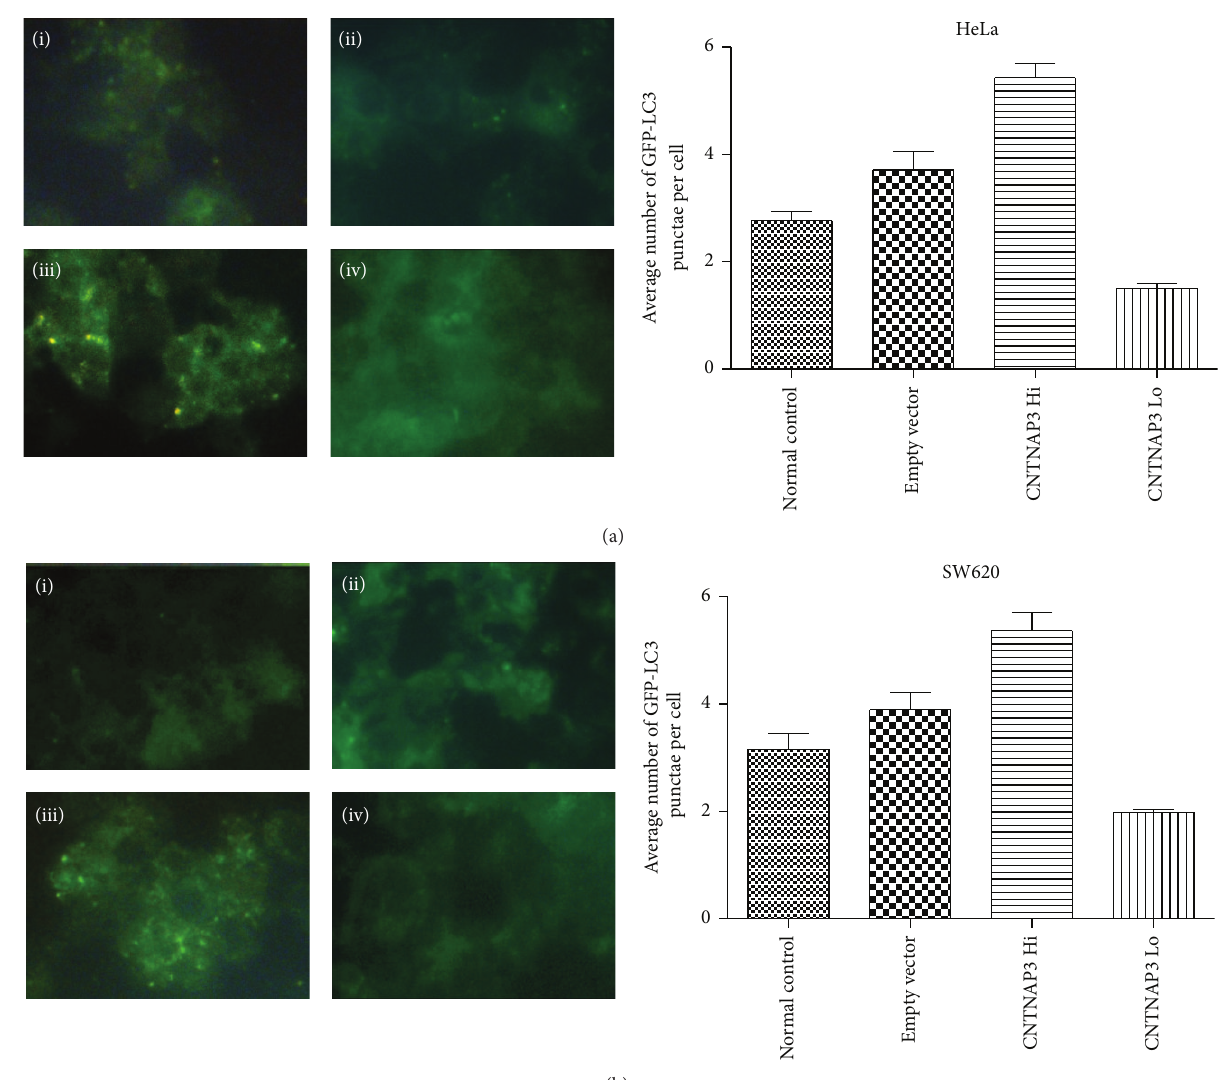
Figure 4: Autophagy phenomenon after CNTNAP3 manipulation. (a) In HeLa cells, the average number of GFP-LC3 punctuated dots per cell of CNTNAP3 overexpression group was 5.434±0.2658 , comparing to 1.507±0.08273 in CNTNAP3 knockdown group and 3.714±0.3373 in empty vector group. (b) In SW620 cells, the average number of GFP-LC3 punctuated dots per cell of CNTNAP3 overexpression group was 5.365 ± 0.3412 , while it was 1.989 ± 0.05458 in CNTNAP3 knockdown group and 3.899 ± 0.3226 in empty vector group. It was shown that autophagy vacuoles significantly increased (HeLa, 𝑃 = 0.161 and SW620, 𝑃 = 0.036 ) and decreased (HeLa, 𝑃 = 0.003 and SW620, 𝑃 = 0.004 ) after CNTNAP3 overexpression and CNTNAP3 siRNA interference compared with cells transfected with empty vectors. ((i) Normal